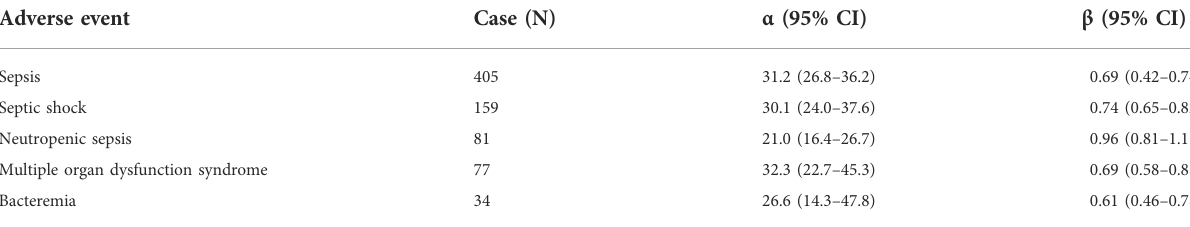
TABLE 3 Time-to-onset analysis of ADC-induced sepsis and related toxicities in the FAERS database. Adverse event Case